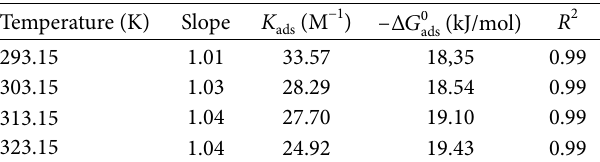
Table 5: Langmuir isotherm parameters for the adsorption of HECG on the C38 steel